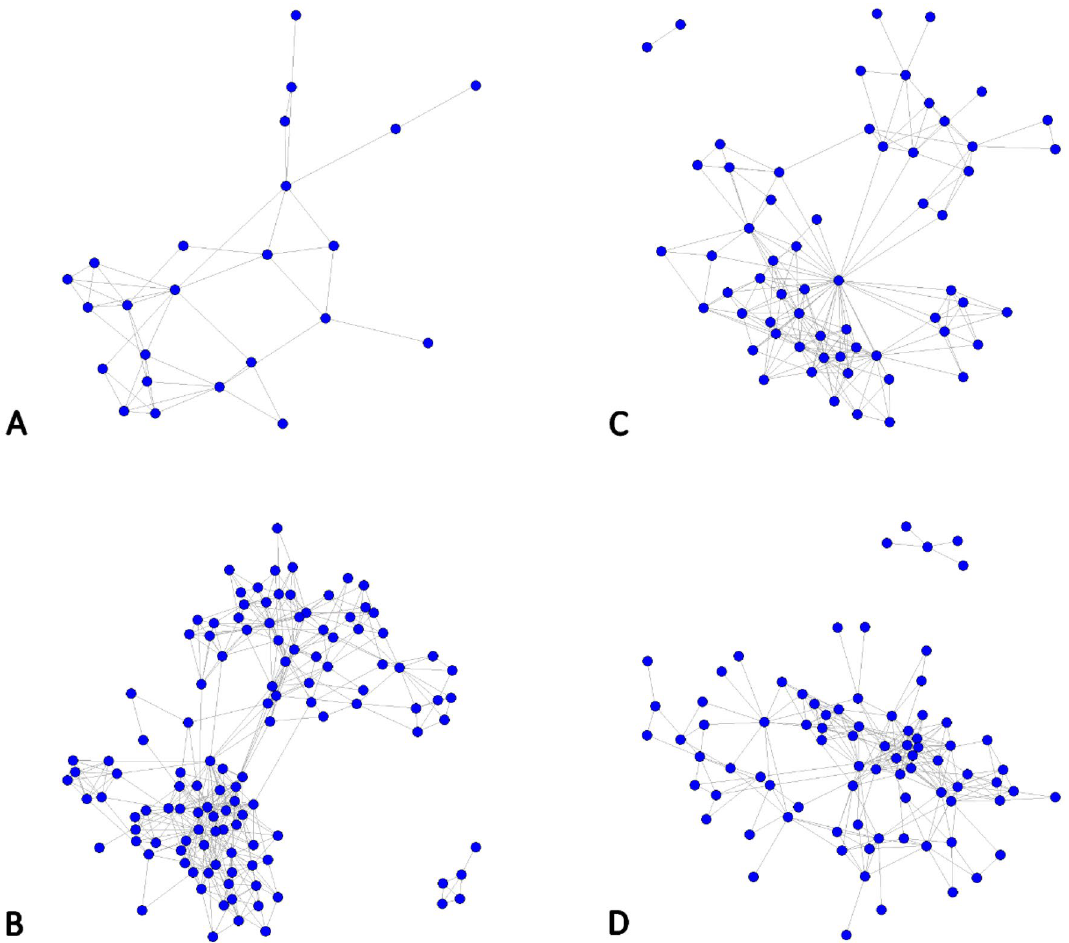
Figure 1. Undirected and unweighted dog contact networks. Nodes represent dogs and edges contacts between two dogs. Within these example networks it can be seen that some dogs are more connected than others. ( A )